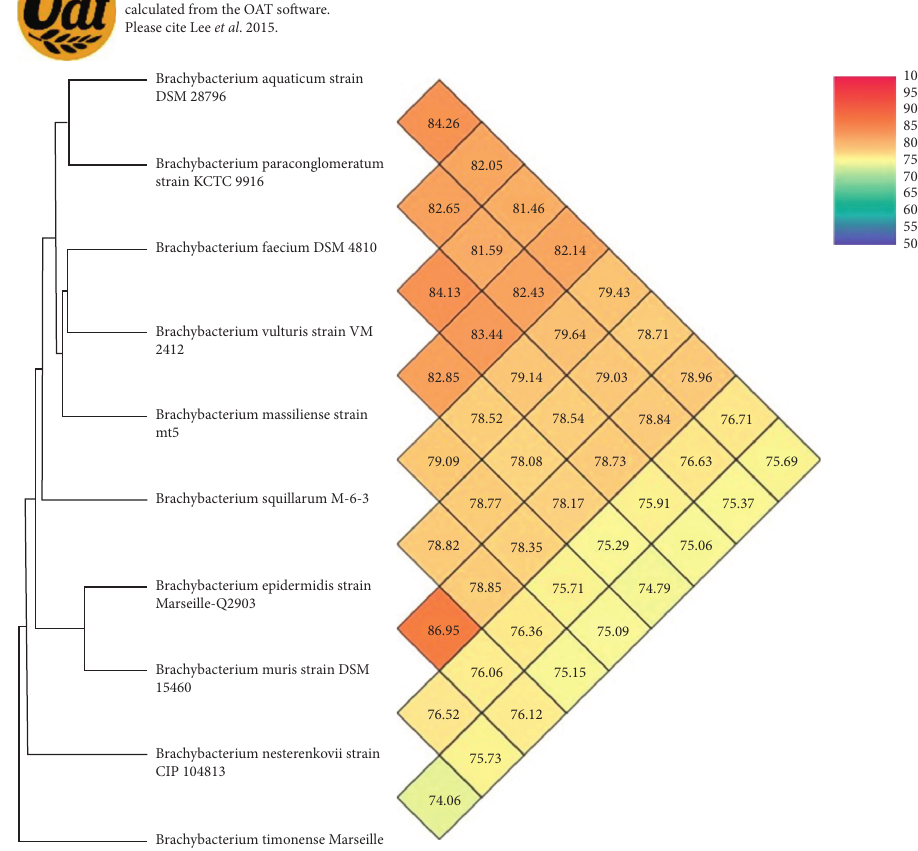
Figure 2: Heatmap generated with orthologous average nucleotide identity (OrthoANI) values calculated using the OAT software, comparing strain Marseille-Q2903T with other closely related bacterial